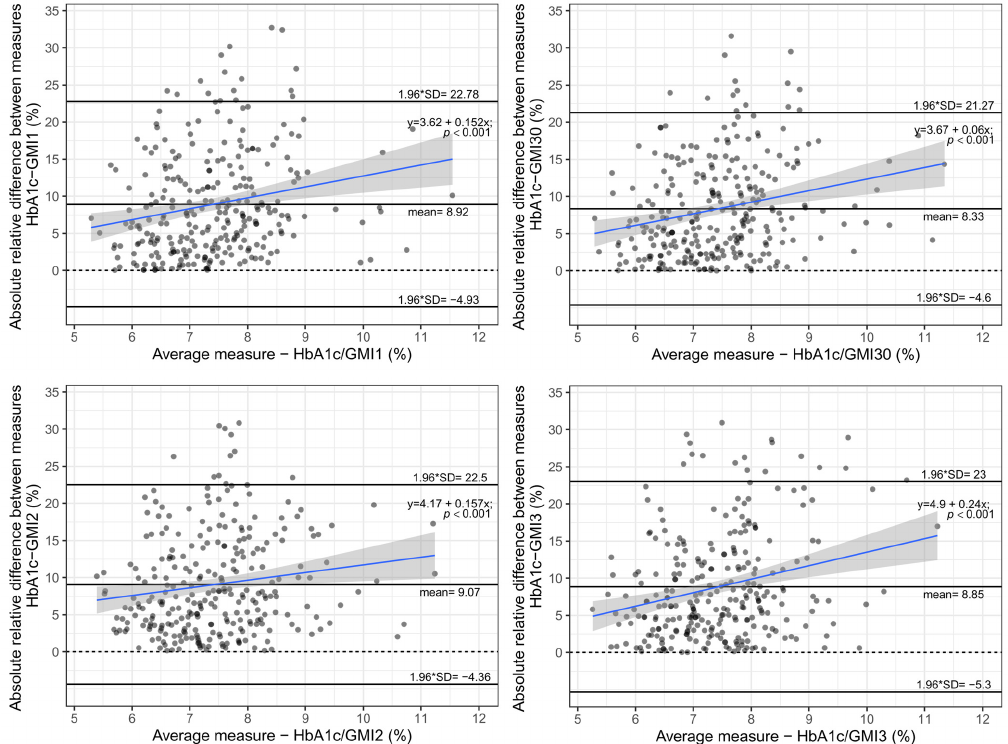
Figure 4. Bland–Altman plot—Absolute value of relative difference between HbA1c and GMI measurements vs. average of two measurements.